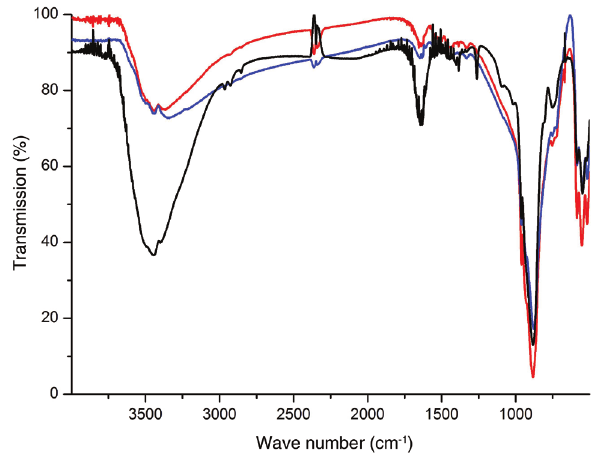
particles; samples A 2